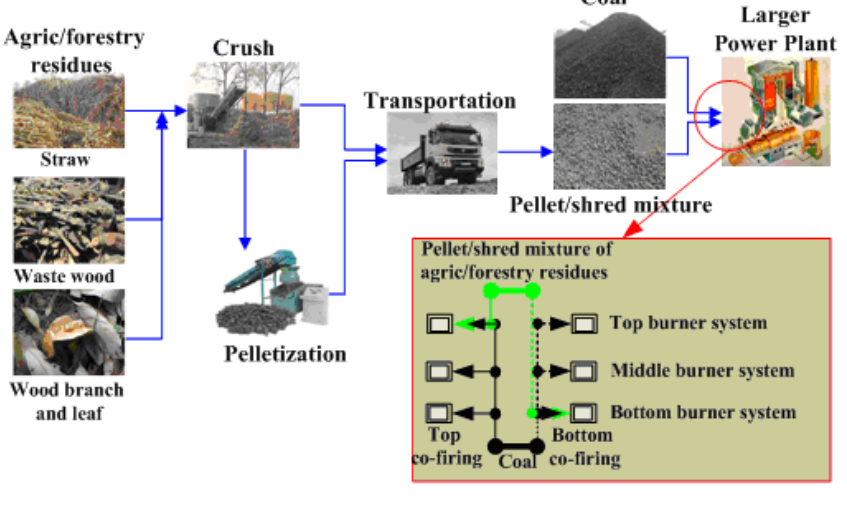
Figure 2. The proposed co-firing model of agro/forestry residues and